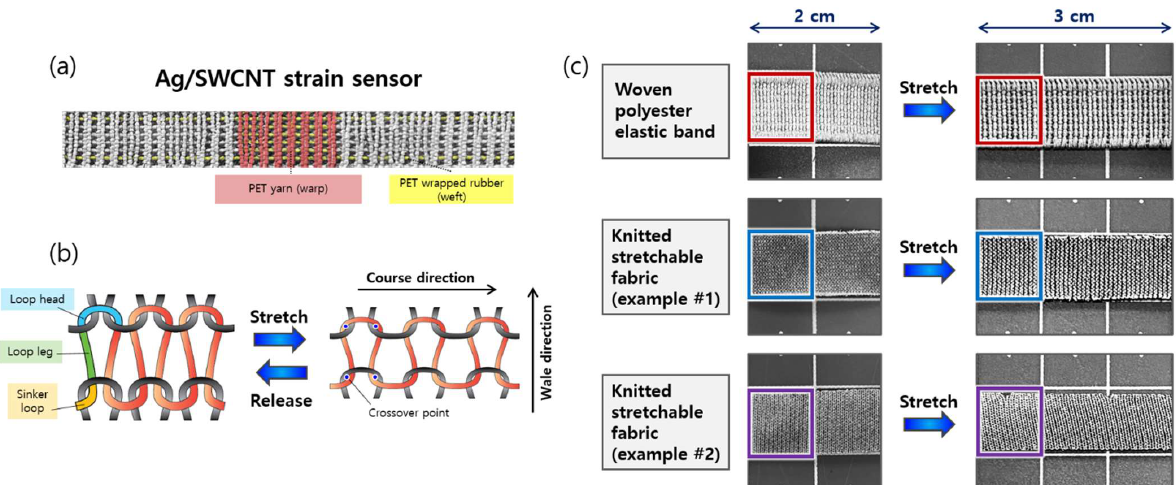
Figure 7. ( a ) Construction of the polyester woven elastic band utilized as the stretchable substrate; ( b ) Schematic diagram of an example knitted fabric in initial and stretched states; ( c ) Dimensional changes of polyester woven elastic band and knitted stretchable fabric examples under 50% applied strain.